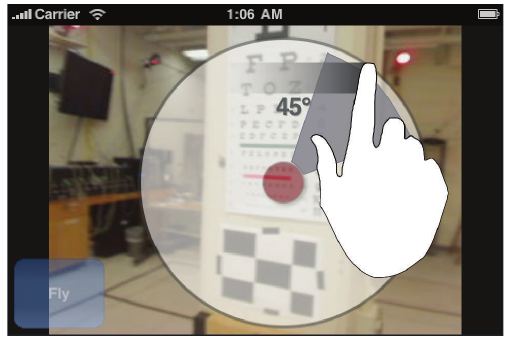
Figure 8: Swiping a finger across the screen causes the device to rotate (yaw) right or